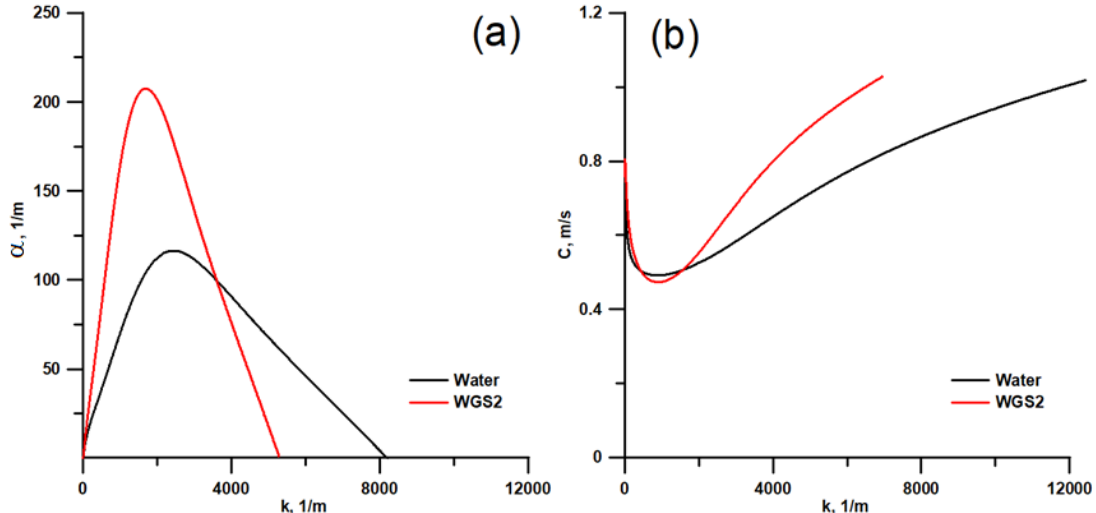
Figure 8. Calculated dispersion relationships. ( a ) Spatial increment of the amplitude growth; ( b ) Phase velocity of the waves. Q = 5.9 mL/s; V G = 22 m/s, downward flow.